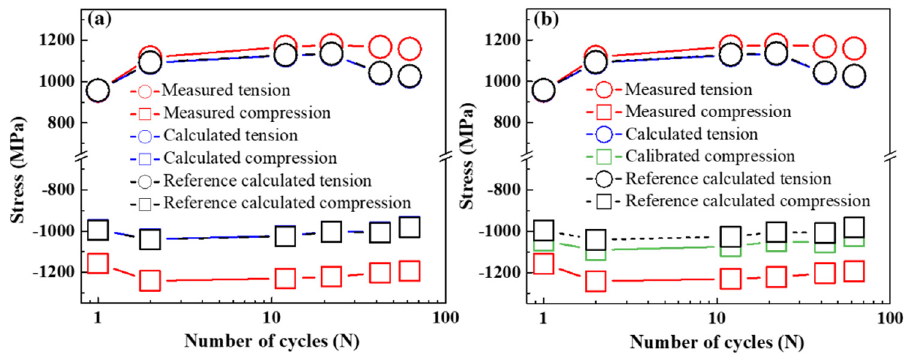
Figure 3. ( a ) The measured stress, calculated stress, and reference calculated stress at the maximum tensile and compressive deformations as a function of fatigue cycles. ( b ) The calculated compressive stress in ( a ) was replaced by the calibrated compressive stress.